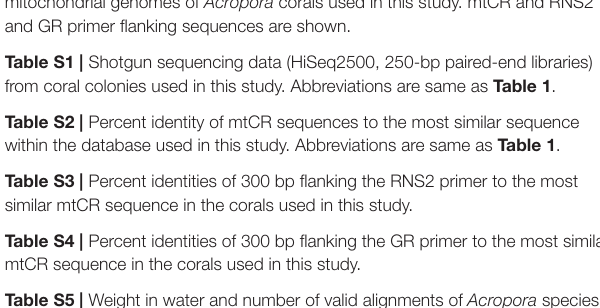
Figure S1 | Electrophoresis of PCR amplicons from eDNA. These were used for library preparation (total amounts of DNA used are shown) and sequenced with a MiSeq (300-bp paired-end libraries). A 100-bp DNA Ladder (TaKaRa, code 3422) was used to determine DNA marker sizes. Amplicon sizes of positive controls